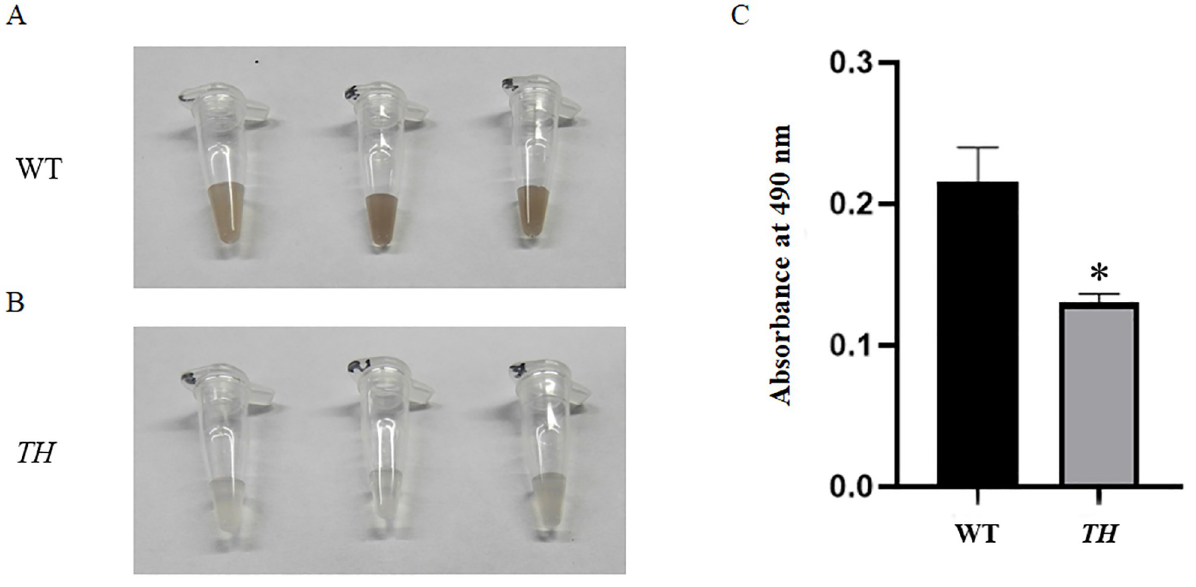
Fig 10. Effects of TH gene knockout on pigmentation. (A) and (B) present the degree of sample melanism of the in vivo melanization. (C) Absorbance at 490 nm for each sample. Three replications are conducted, and the data are presented as mean ± SE. P = 0.0149.